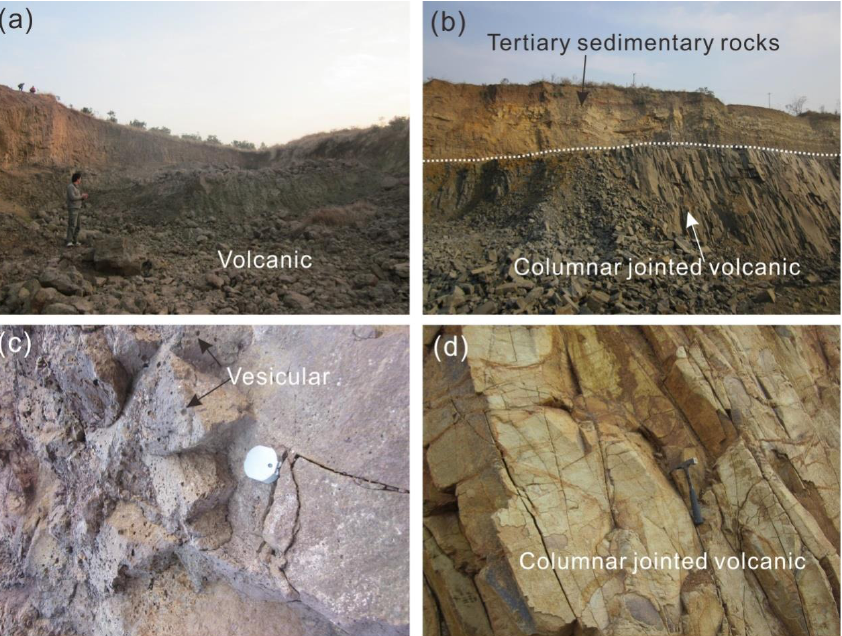
Figure 2. Field photographs showing the various lithologies of the volcanic rocks in the Jiangling Basin. ( a ) Fresh volcanic rocks; ( b ) Tertiary sedimentary rocks overlapping volcanic rocks with columnar jointing; ( c ) Vesicular volcanic rocks; and ( d ) Volcanic rocks with columnar jointing. The Paleogene volcanics are fine-grained and occasionally porphyritic consisting of plagioclase, chlorite, and opaque minerals (Figure 3). Plagioclase occurs as small laths and a few microphenocrysts. The plagioclase laths commonly show quench textures, especially along the peripheries of the pillows. Chlorite is mainly present in the groundmass and formed at the expense of pyroxene. The laths are mostly filled with chlorite and quartz and some are filled with calcite, epidote, and prehnite.